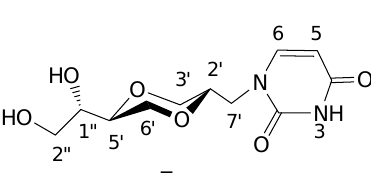
Figure 6. Structure 7a .